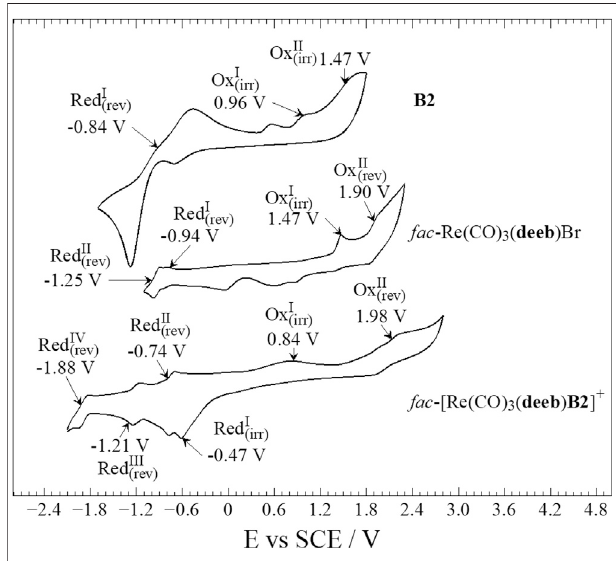
TABLE 1 | Photophysical properties of the uncoordinated B2 (Carreno et al., 2016a) ligand and fac -[Re(CO) 3 ( deeb ) B2 ] + . Compound